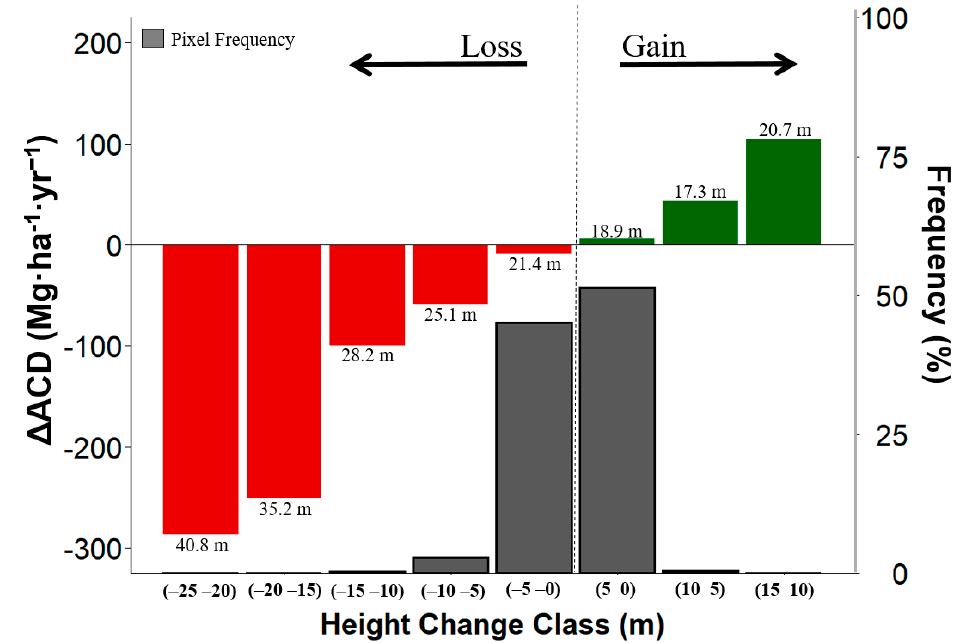
Figure 6. Average changes in aboveground forest carbon stocks within classes of height changes between years for all the LiDAR data intervals. These changes in height indicate how many meters any tree canopy area gained or lost on average during the period analyzed. It also shows the mean canopy height (value below and above the red and green bars, respectively) that have undergone some change in the canopy (in terms of gain and loss). In this way, we detected, on average, the height of the trees that were more severely a ff ected by losses. The grey bars represent the frequency in which we found the results, measured by the number of